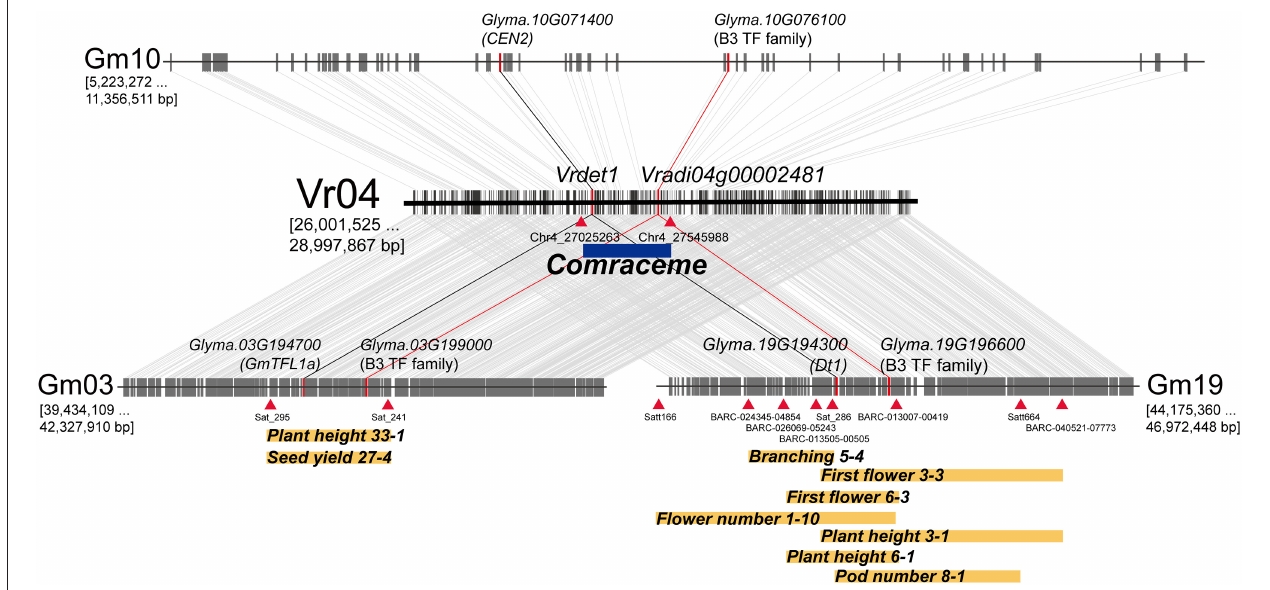
FIGURE 4 | Soybean genomic blocks syntenic with the 3Mb genomic region of mungbean harboring the Comraceme locus (Vr04: 26,001,525 to 28,997,867 bp). The soybean syntenic blocks were physically located on 3 chromosomes, Gm03 (39,434,109 to 42,327,910 bp); Gm10 (5,223,272 to 11,356,511 bp); and Gm19 (44,175,360 to 46,972,448 bp). The syntenic blocks on Gm03 and Gm19 contain previously known QTLs associated with inflorescence-related agronomic traits. Dt1 ( Glyma.19G194300 ) and VrDet1 , which are responsible for determinate vegetative growth in soybean and mungbean, respectively, also show conserved colinearity. Other homologous genes of soybean, GmTFL1a ( Glyma.03G194700 ) and CEN2 ( Glyma.10G071400 ), are also present on Gm03 and Gm10, respectively. The genes Vradi04g00002481 , Glyma.03G199000, Glyma.10G076100 , and Glyma.19G196600 , which encode proteins of the B3 TF subfamily, are maintained in the